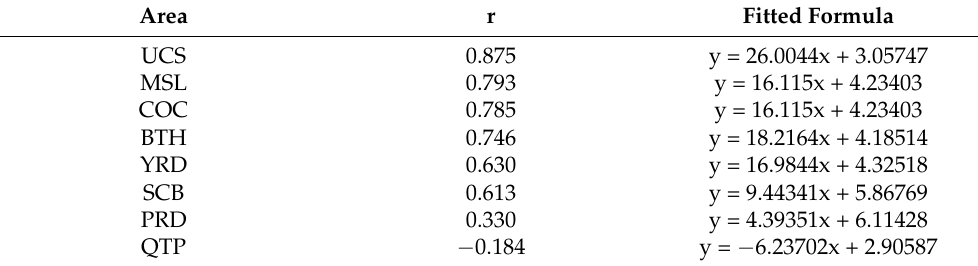
Table 5. Correlation between OCC LT and NDVI.